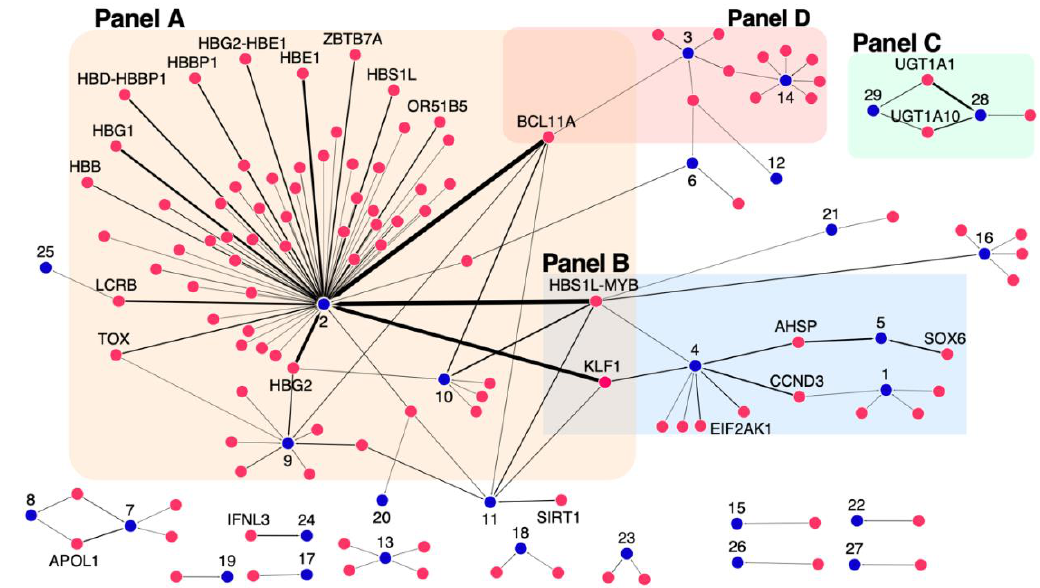
Figure 4. Network diagram of gene–phenotype interactions. The network depicts relationships between genes and phenotypes of haemoglobinopathies. Genes (red nodes) are connected to phenotypes (blue nodes) by edges. The thickness of the edges represents the corresponding IthaScore, where a stronger edge indicates a greater weight for the gene-phenotype relationship. Only gene–phenotype relationships with gene scores ≥0.1 are displayed on the network for better visualisation, while gene names are only shown for gene scores ≥0.2. The “Phenotype ID” shown in Table 2 is used to label phenotypic nodes, as follows: (1) Abnormal red blood cell count, (2) Hb F levels, (3) Stroke, (4) Anaemia, (5) Ineffective erythropoiesis, (6) Osteonecrosis/Avascular necrosis, (7) Focal segmental glomerulosclerosis, (8) Proteinuria, (9) Hb F response to hydroxyurea, (10) F-cell numbers, (11) Globin gene regulation, (12) Bacteremia, (13) Abnormal white blood cell count, (14) Acute chest syndrome, (15) Osteoporosis, (16) Abnormal platelet count, (17) Left ventricular diastolic dysfunction, (18) Pain, (19) Abnormal serum iron concentration, (20) Hyperuricemia, (21) Abnormal hematocrit, (22) Increased serum ferritin, (23) Vaso-occlusive crisis, (24) Response to Hepatitis C treatment, (25) Increased Hb A2 levels, (26) Erythropoietin (EPO) levels, (27) Haemolytic anaemia, (28) Bilirubin levels and (29) Gallstones.